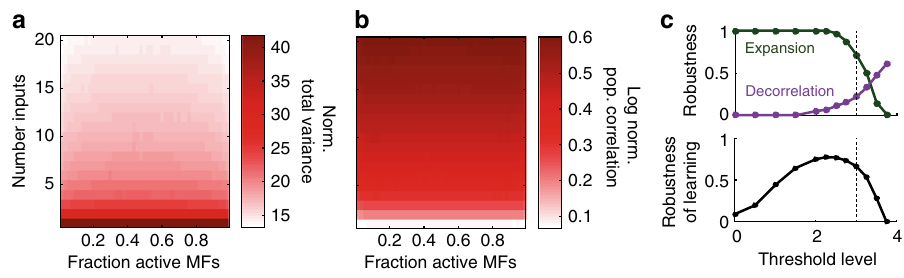
Fig. 4 Dependence of coding space and correlation on connectivity and the role of thresholding in controlling the expansion and decorrelation. a Normalized total variance and b log normalized population correlation for networks of linear granule cells (i.e. in the absence of a threshold). Correlation radius is σ = 20 μ m. c Top: robustness of expansion (green) and decorrelation (purple) for varying levels of granule cell (GC) threshold. Dotted line indicates the experimentally estimated value of threshold (3 of the 4 mossy fi bers, MFs). Bottom: Robustness of learning for varying